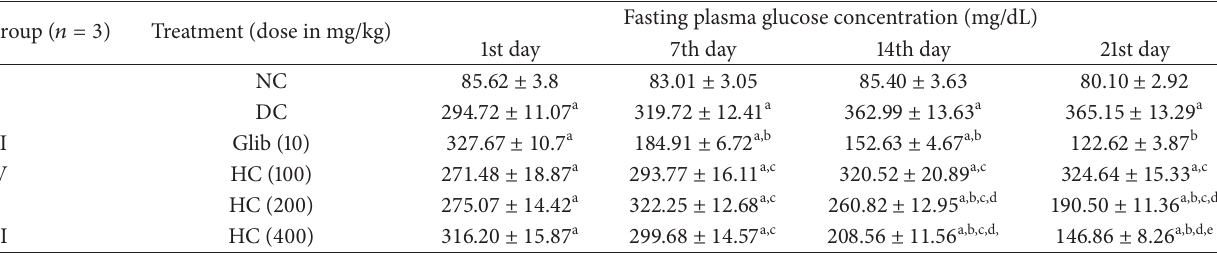
Table 1: Effect of HC on FPG in streptozotocin-induced diabetic rats.